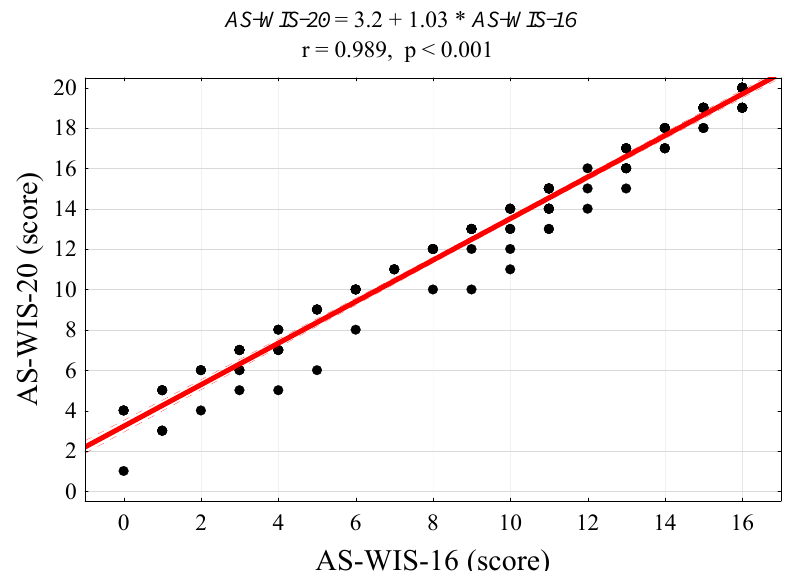
Figure 1. A correlation diagram between work disability risk scores on the original scale (AS-WIS-20) and work disability risk scores on the shortened version of the scale (AS-WIS-‘6), Pearson’s correlation coefficient and regression line.